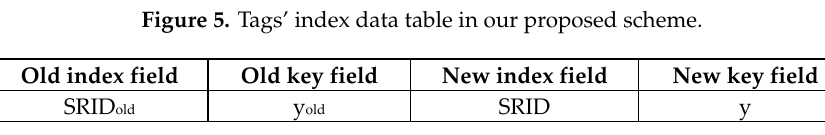
Figure 6. Readers’ index data table in our proposed scheme.